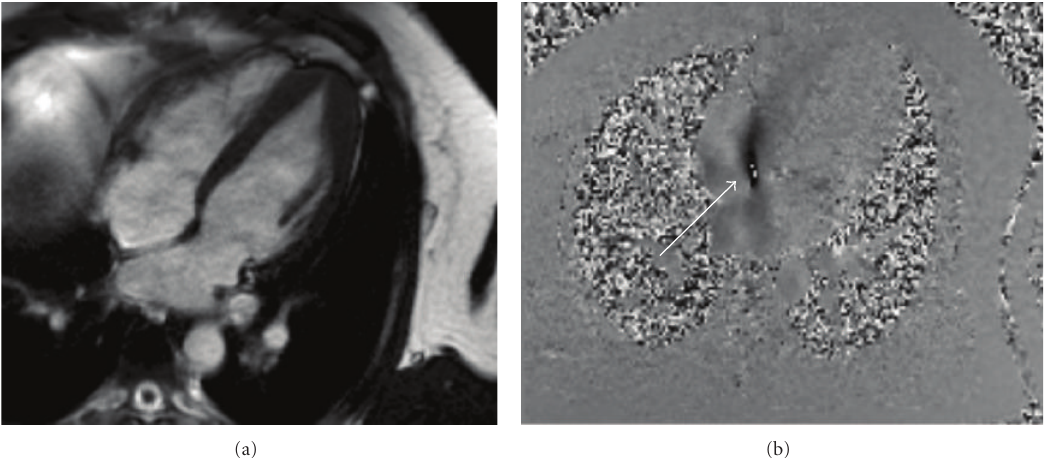
Figure 5: A patient with known apical HCM in whom transthoracic echocardiography had suggested a secundum ASD. (a) Cine 4 chamber image showing apical hypertrophy (b) flow sequence planned using the 4 chamber view shows flow across the intra atrial septum from left to right (arrowed), confirming the diagnosis. In this case, although the right heart does not appear dilated, the Qp:Qs was calculated as 2 showing the presence of a significant